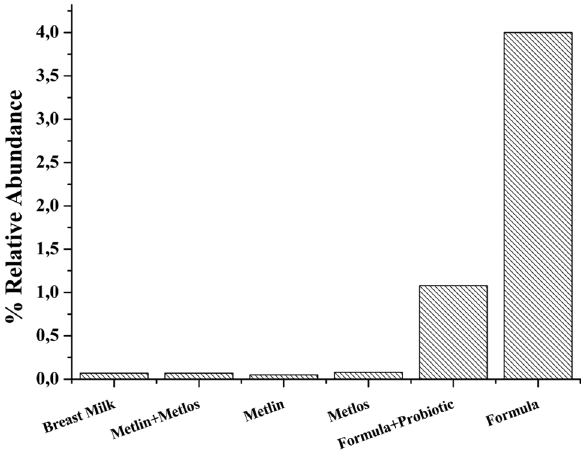
Figure 2. Clostridium population changes after three months of age in the different groups of